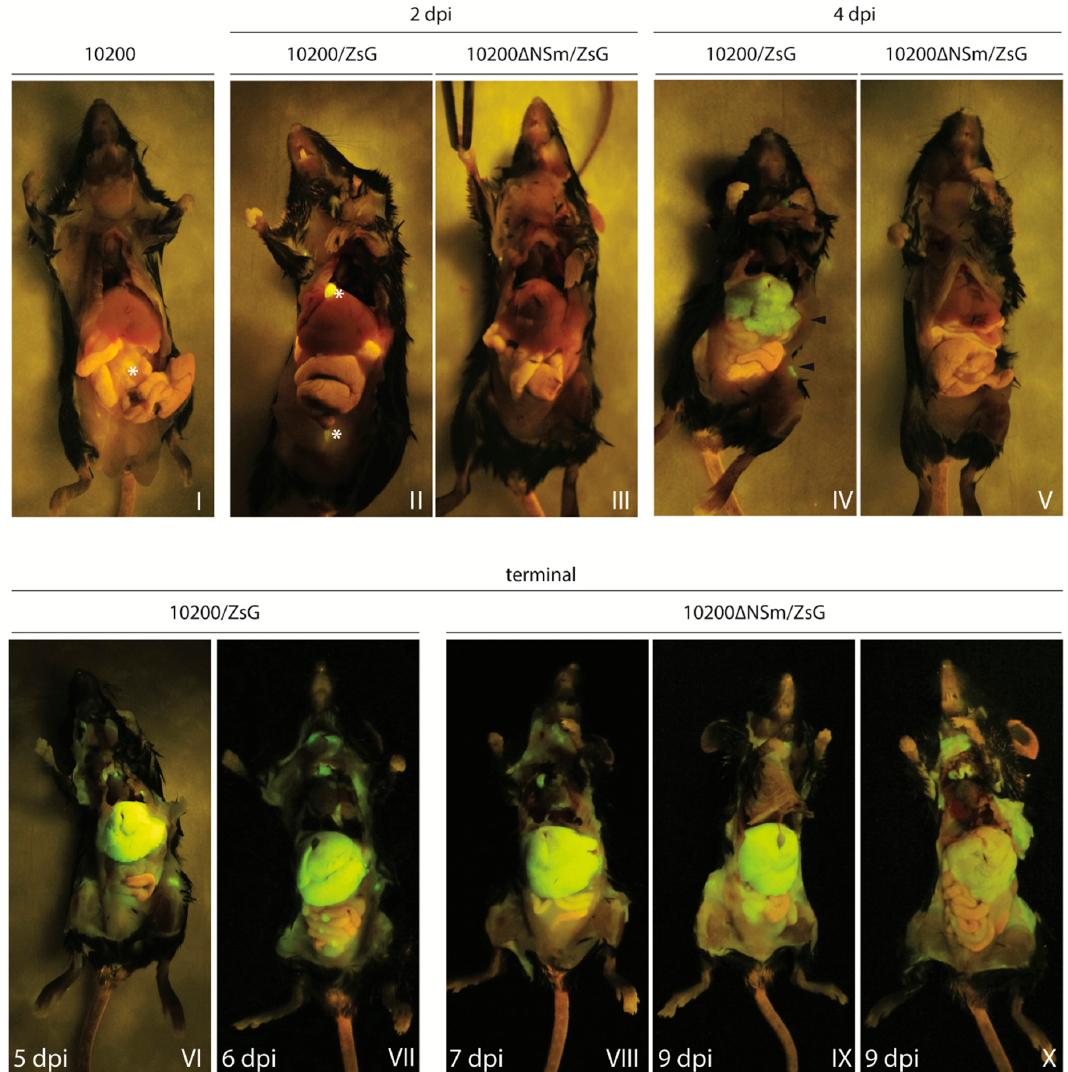
Figure 4. In situ detection of ZsG fluorescence in Ifnar − / − mice infected with 10200, 10200/ZsG, or 10200 ∆ NSm/ZsG. Ifnar − / − mice were infected subcutaneously with 100 TCID 50 of either 10200/ZsG (n = 11) or 10200 ∆ NSm/ZsG (n = 11) and euthanized at 2 dpi (n = 3) or 4 dpi (n = 3) or allowed to progress until end-point euthanasia criteria were reached (terminal group, n = 5). A single 10200-infected mouse was also euthanized 2, 4, or 5 dpi to determine levels of autofluorescence and background fluorescence, with the 2 dpi animal represented in Panel I. In Panels I and II, the strong autofluorescence observed in the gall bladder and bladder, and slight autofluorescence in the intestinal tract are marked with *. At 2 dpi (Panels II and III), ZsG fluorescence was not detected in any tissue. At 4 dpi (Panels IV and V), ZsG fluorescence was detected in the livers and inguinal lymph nodes (both marked with arrowhead) of 10200/ZsG-infected mice (n = 3), but fluorescence was not observed in any of the 10200 ∆ NSm/ZsG-infected mice (n = 3). In 10200/ZsG-infected terminal animals (Panels VI and VII), extensive ZsG fluorescence was observed in the liver and lymphoid tissues (brachial, mediastinal, inguinal, and lumbar lymph nodes) in animals euthanized at 5 or 6 dpi. Levels of fluorescence in the tissues were similar between animals at these terminal time points. In 10200 ∆ NSm/ZsG-infected terminal animals (Panels VIII–X), fluorescence was detected in the same tissues as in 10200/ZsG-infected animals. Fluorescence intensity, however, was inconsistent between the 10200 ∆ NSm/ZsG-infected mice at this time point, with one animal euthanized at 9 dpi (Panel X) showing markedly lower ZsG expression in the liver than the other 10200 ∆ NSm/ZsG-infected mice euthanized at 7 and 9 dpi.